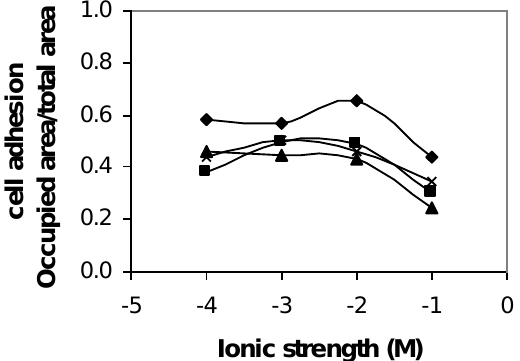
Figure 3. Adhesion of Y. lipolytica IMUFRJ to glass at pH 3 ( ♦ ), pH 5 ( ■ ), pH 7 ( ▲ ), and pH 9 ( x ) and ionic strenth varying from 10 − 4 M to 10 − 1 M. The error bars are omitted for a clearer visualization. The standard deviation varied from 2% to 11%.